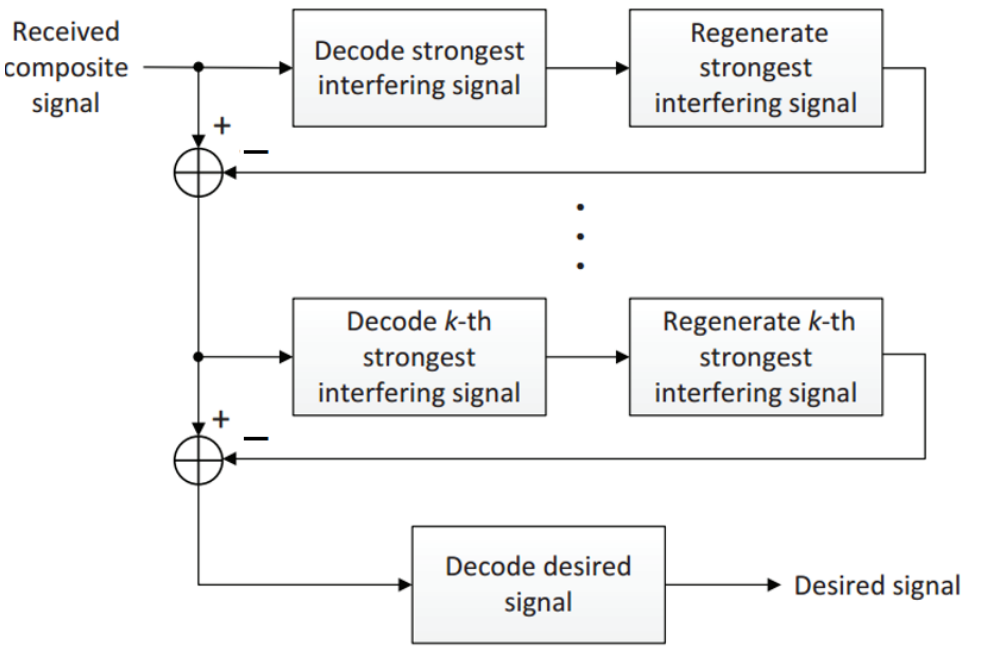
Figure 2. Block diagram of the SIC